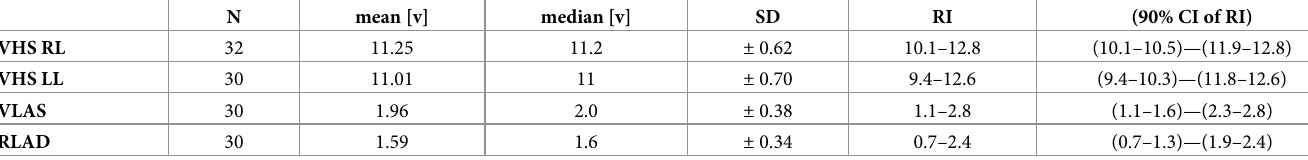
Table 3. Mean, median, SD, RI (95% prediction interval) and 90% CI for VHS, VLAS and RLAD.